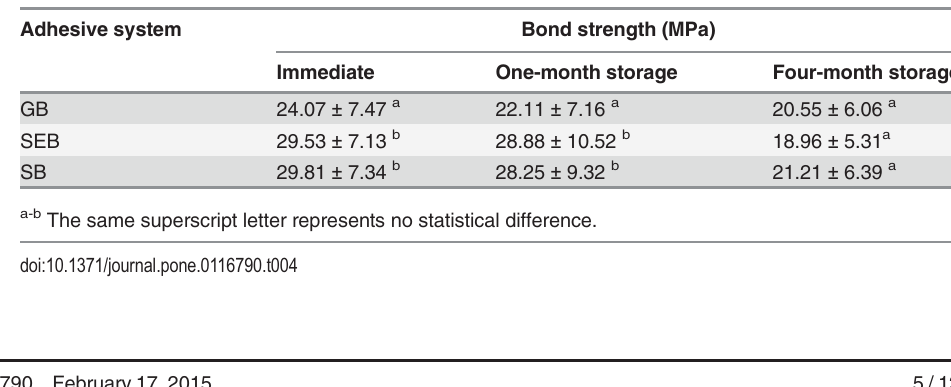
Table 4. Bond strength of the tested materials (n = 20, x ̄ ±